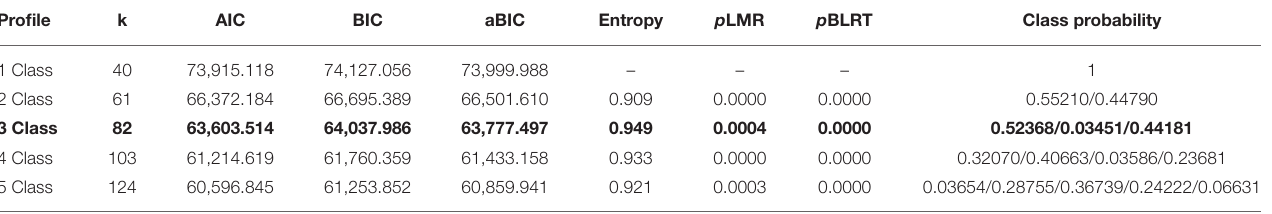
Values in bold indicate the best fitting model. AIC, Akaike Information Criterion; BIC, Bayesian information criterion; aBIC sample size-adjusted Bayesian information criterion; pLMR, p-values for Lo–Mendell–Rubin adjusted likelihood ratio test for K vs. K-1 profiles; pBLRT, p-values for Bootstrapped Likelihood-Ratio